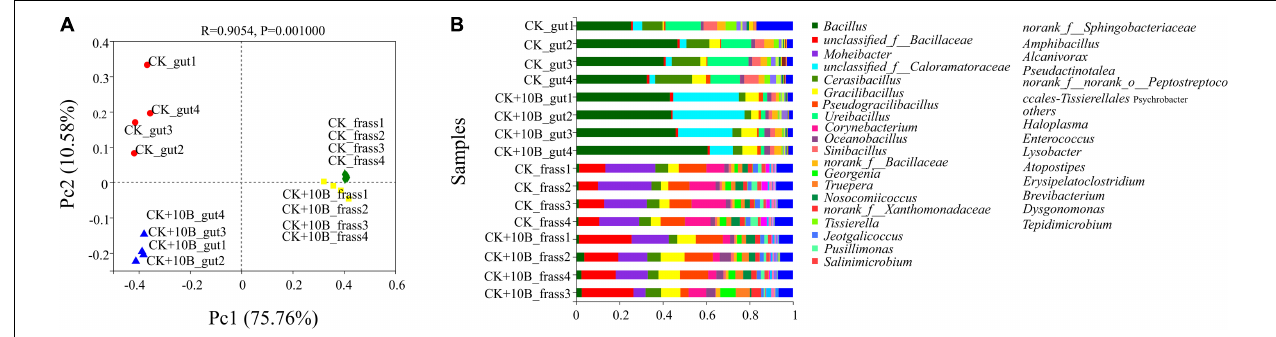
FIGURE 3 | (A) Principal coordinate analysis (PCoA) score plot of different samples based on weighted UniFrac metrics. Three categories were clustered. (B) Gut microbial composition at the genus level (the relative abundance of microbes > 0.01) in different samples.